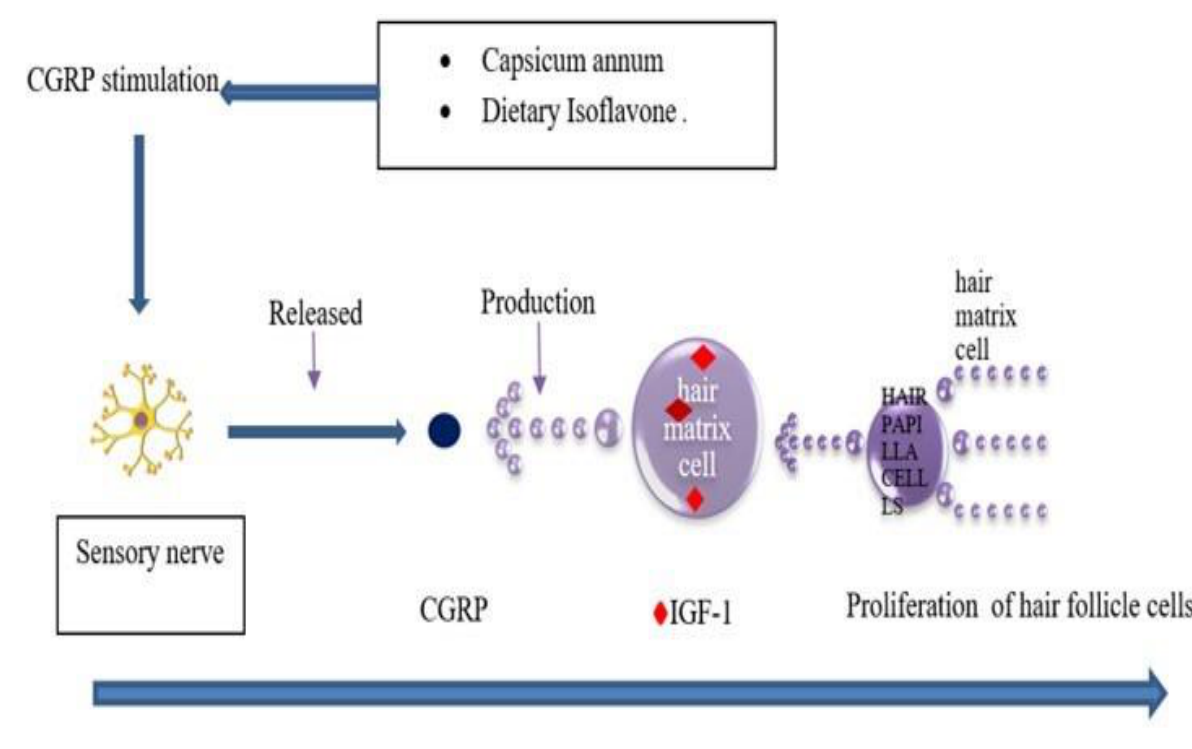
Figure 8. Drugs affecting the IGF factor. Table 7. Herbal drugs acting on IGF. Biological